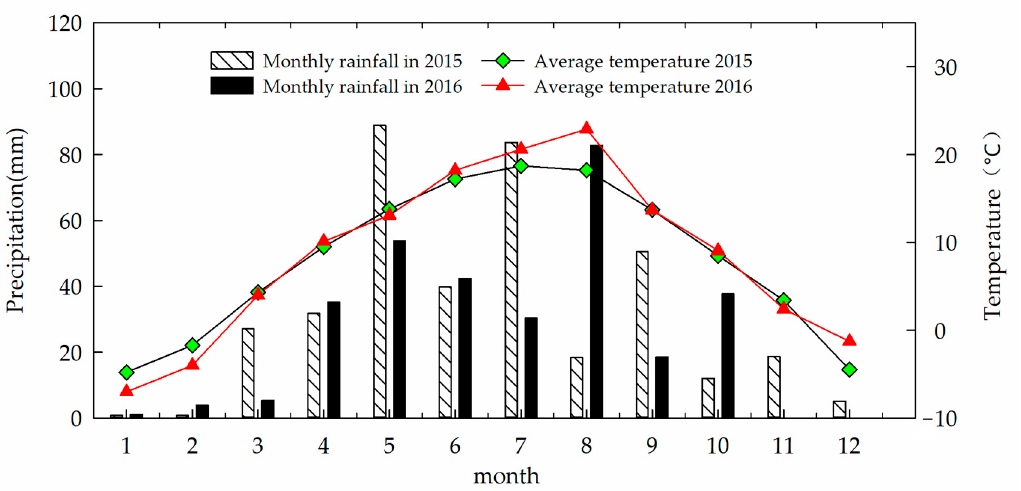
Figure 1. Precipitation and air temperature at study area in 2015 and